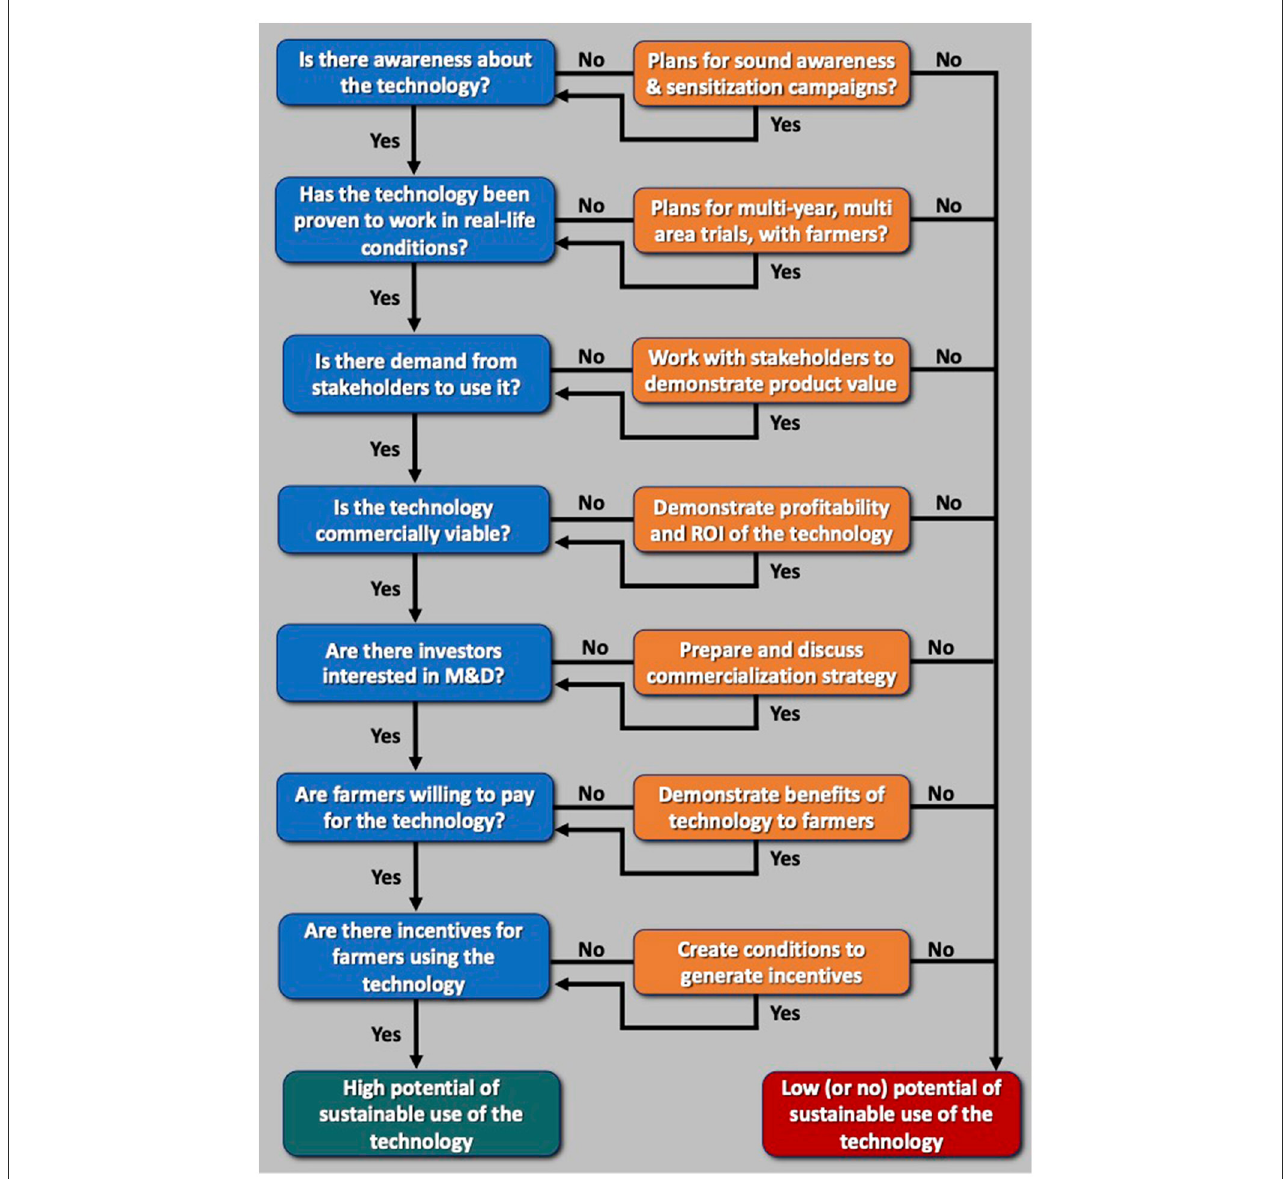
FIGURE1 A “code” that has been proven to work for the sustainable use of registered aflatoxin biocontrol products by smallholder farmers in African countries. This basic process, with modifications where necessary, applies for any other aflatoxin management